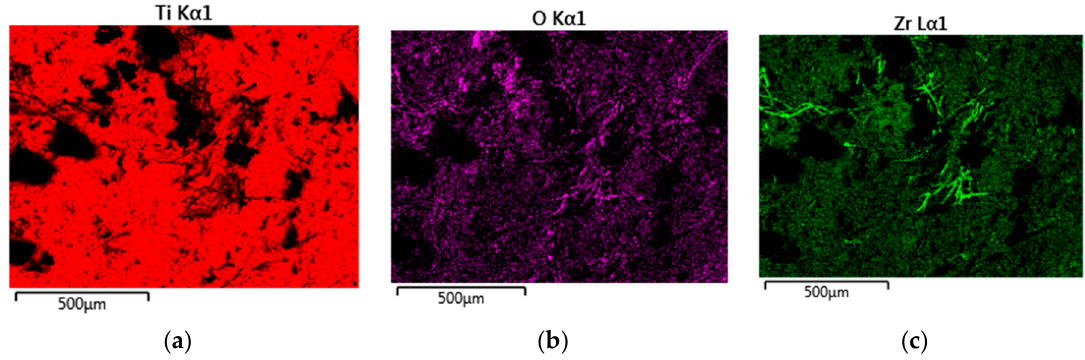
Figure 8. Element composition map of molted large Ti sample (SEM, EDS analysis) ( a ) titanium; ( b ) oxygen; ( c ) zirconium. Table 3. EDS chemical area analysis results for melted titanium samples in solar furnace. Sample